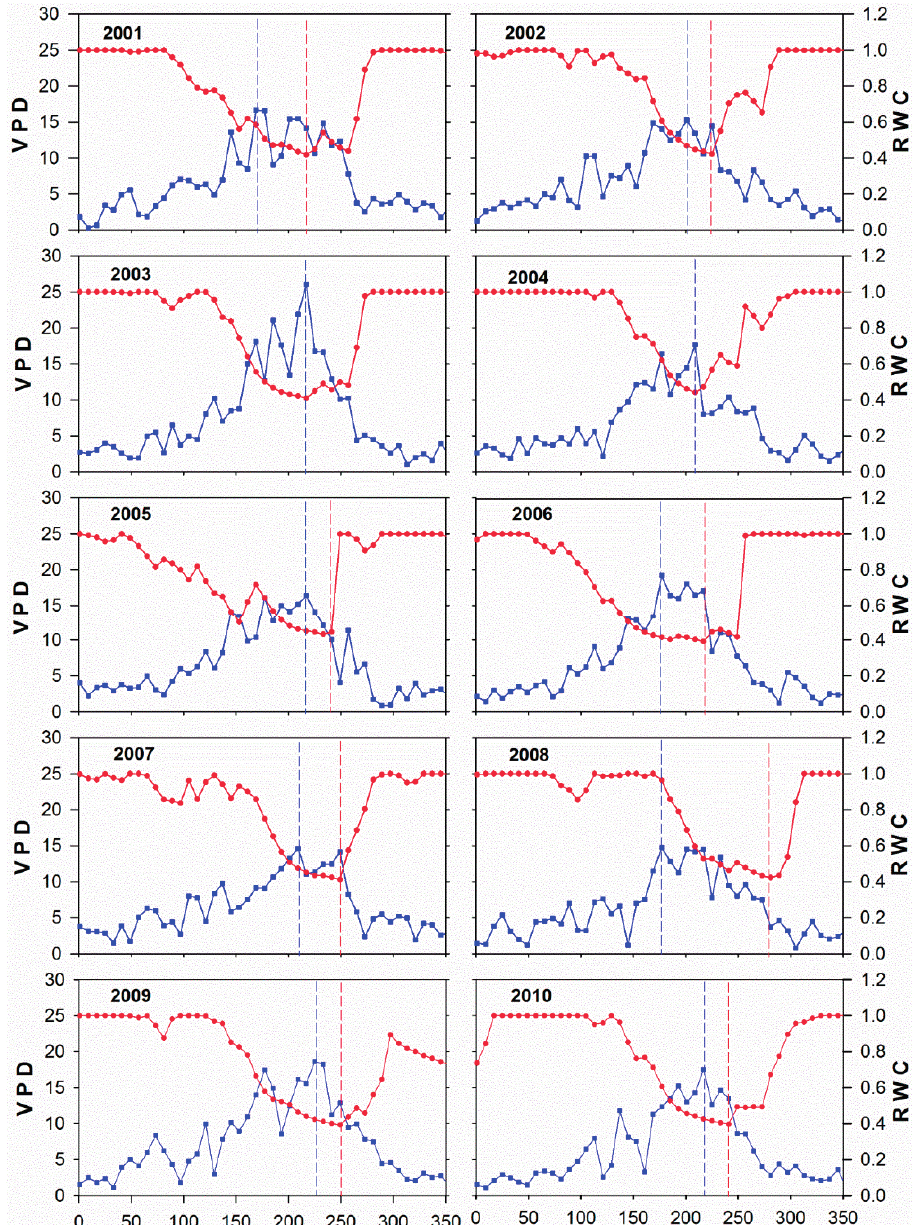
Figure A2. Comparison between 8-day mean vapor pressure deficit (VPD, in blue) and 8-day mean relative soil water content (RWC, in red) from 2001 to 2010. Blue dashed lines represent the yearly maximum for VPD and red dashed lines represent the yearly minimum value for